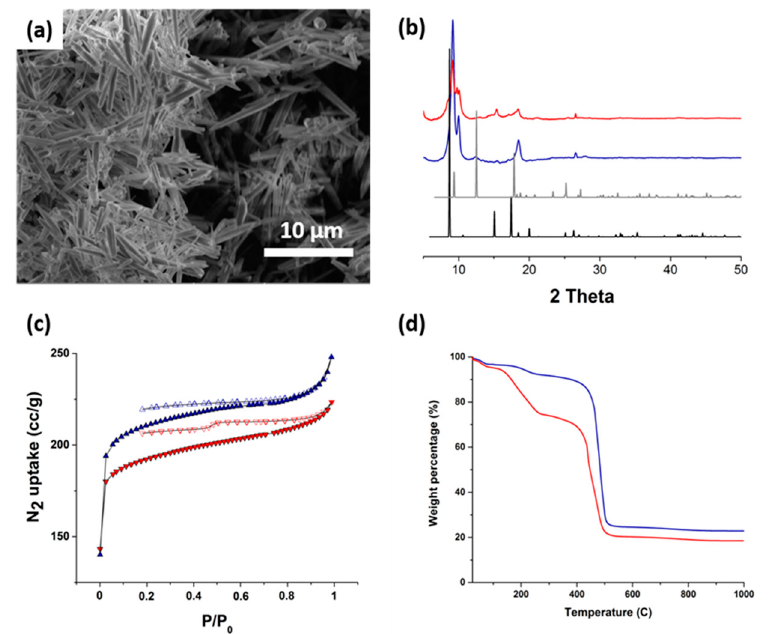
Figure 2. ( a ) SEM images of the material obtained at 90 °C; ( b ) PXRD; ( c ) BET and ( d ) TGA analyses for the materials obtained at 70 °C (red) and 90 °C (blue). The black and gray XRD patterns correspond, respectively, to the simulated XRD patterns of high-temperature and low-temperature phases of MIL-53 (Al).